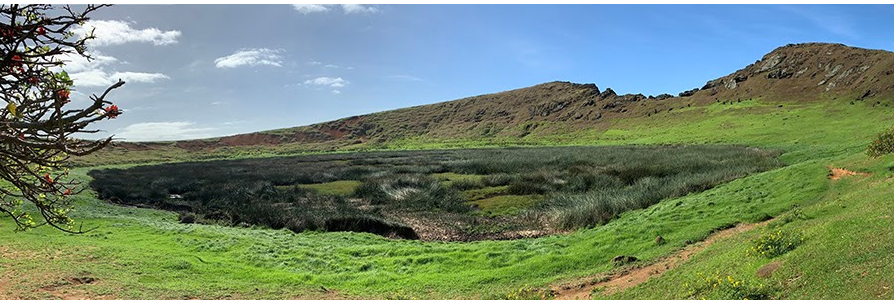
Figure 7. Rano Raraku crater lake, completely dry in May 2019.